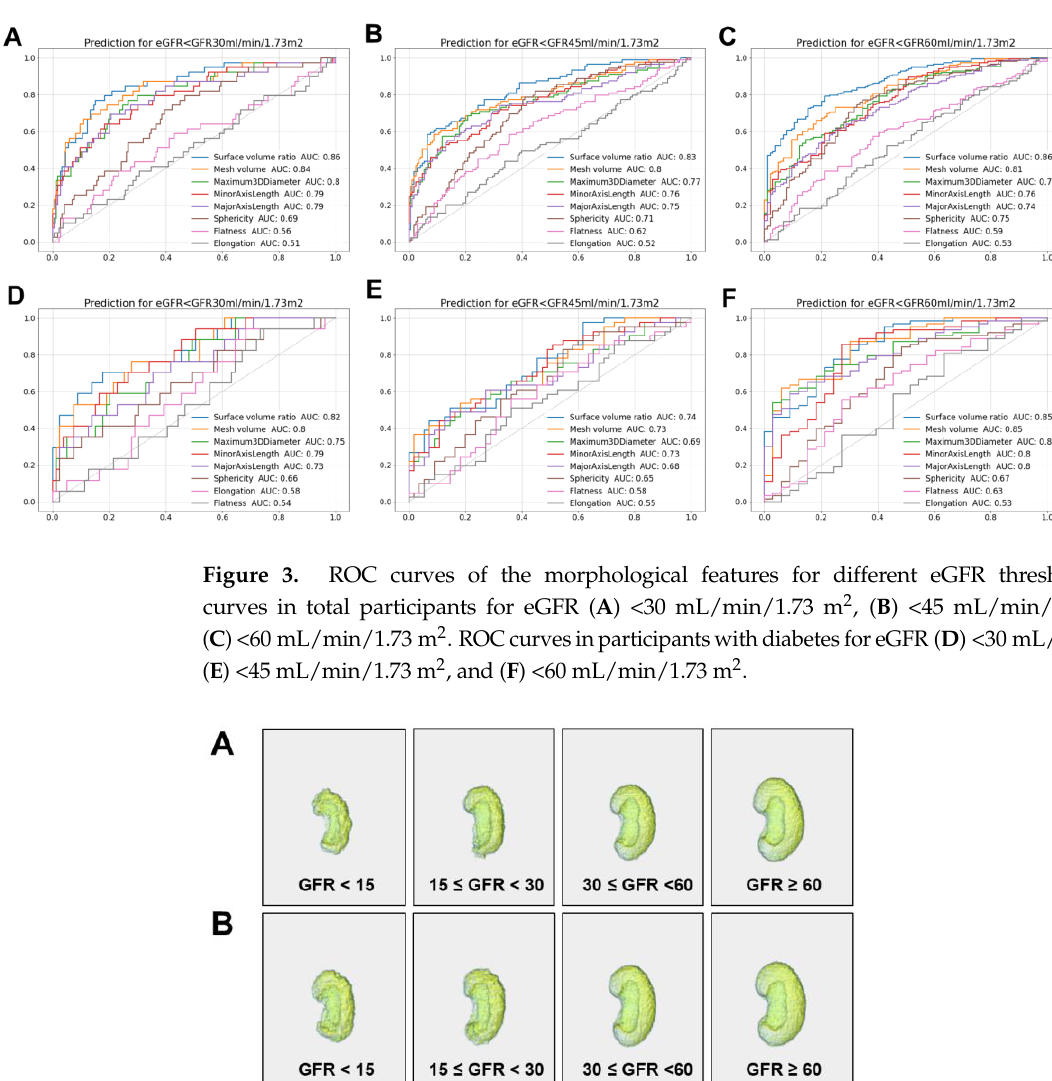
Table 3. Linear regression analysis on the determinants of surface-area-to-volume ratio.